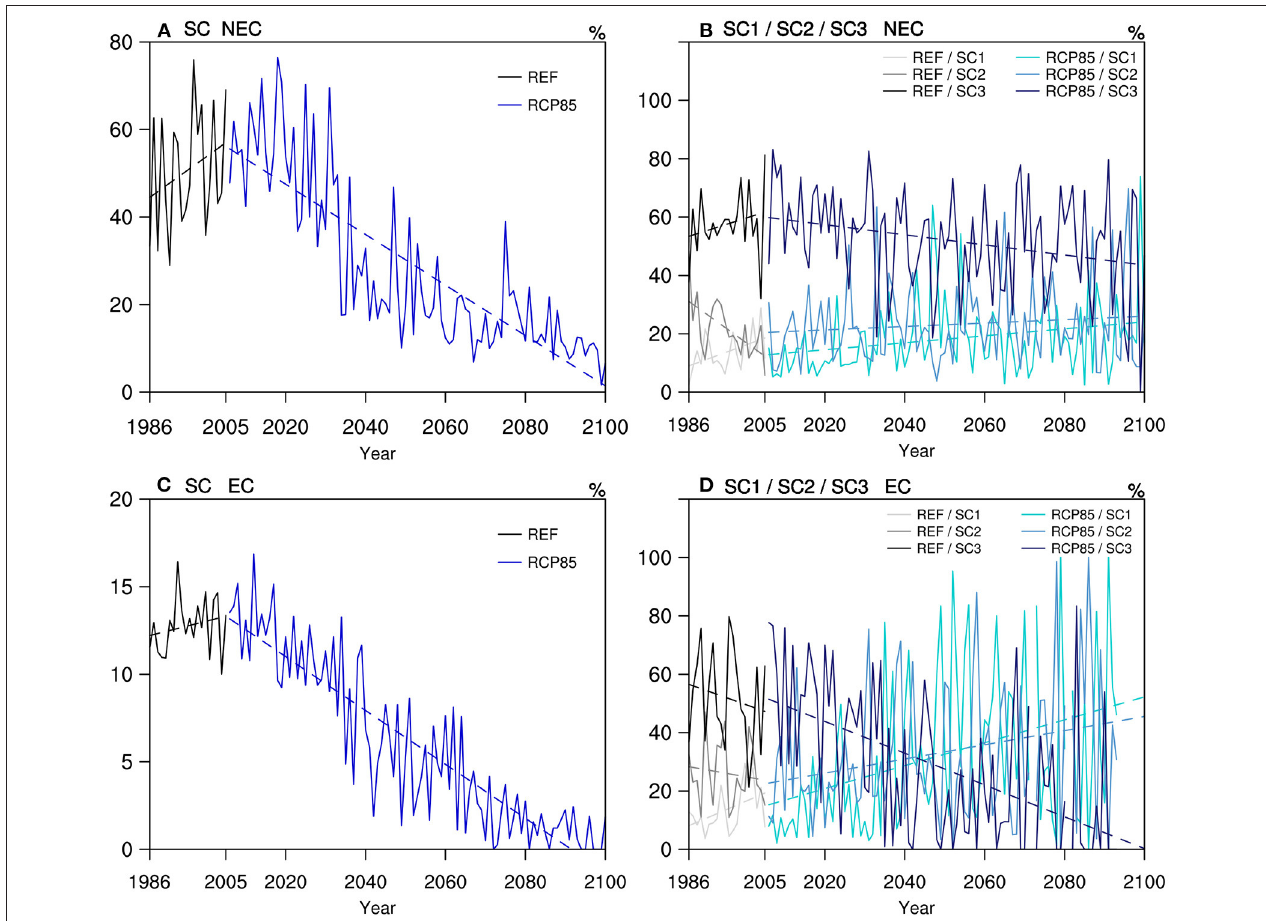
FIGURE 13 | Time series of control and projected indexes of regional impact of chilling damage (SC, unit: %) and of regional coverage of chilling damage with different intensity (SC1/SC2/SC3, unit: %) averaged over the (A,B) Northeast China and (C,D) Central and East China during 1986–2100. The light gray, dark gray, and black solid lines are for the historical simulation, and the light, bright, and dark blue lines represent the projection results under RCP8.5 scenario. The corresponding dotted lines indicate the linear